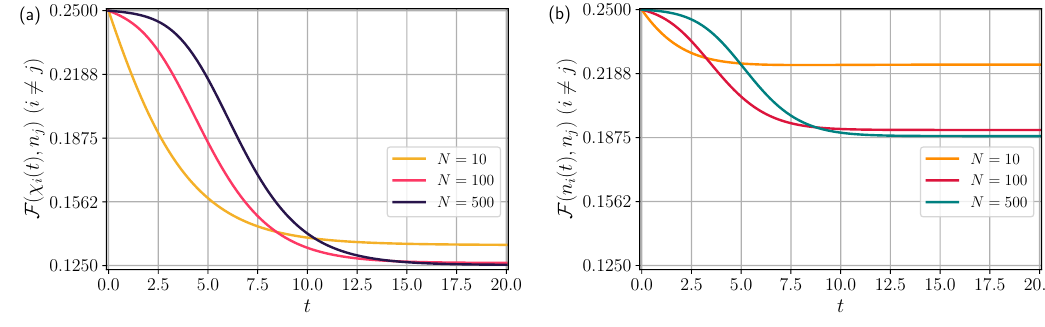
Figure 6 . The overall OTOC F ( χ i ( t ) , n j ) in (a) and F ( n i ( t ) , n j ) in (b), for i 6 = j and different values of N . Both the OTOCs display pronounced finite-sized effects in their late-time values, which remain finite as N → ∞ , in contrast with that of F ( χ